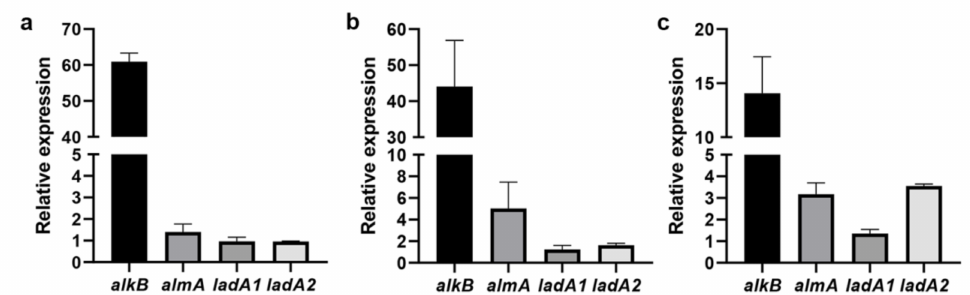
Figure 5. The relative expression levels of four alkane hydroxylase genes in C 20 ( a ), C 24 ( b ), and C 32 ( c ) detected by RT-qPCR analysis. The relative expression levels of four alkane hydroxylase genes in diverse alkanes (C 20 , C 24 , C 32 ) to the expression in AcNa were normalized by that of rpoB . The 2 −(cid:52)(cid:52) Ct method was used to calculate the fold change of the normalized mRNA expression